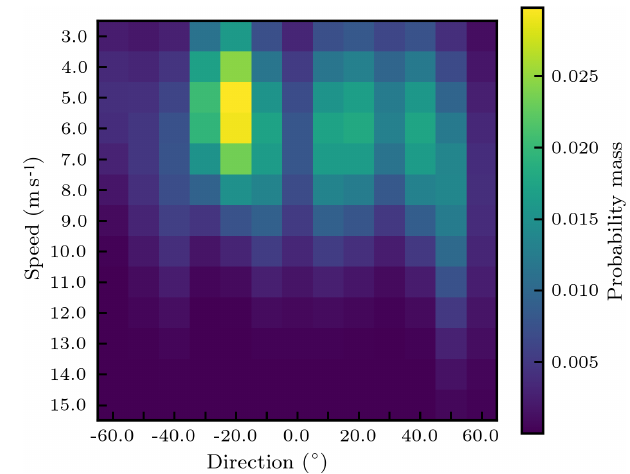
Figure 5. Annual wind speed and direction probability mass func- tion used in the 11-turbine wind plant optimization study.